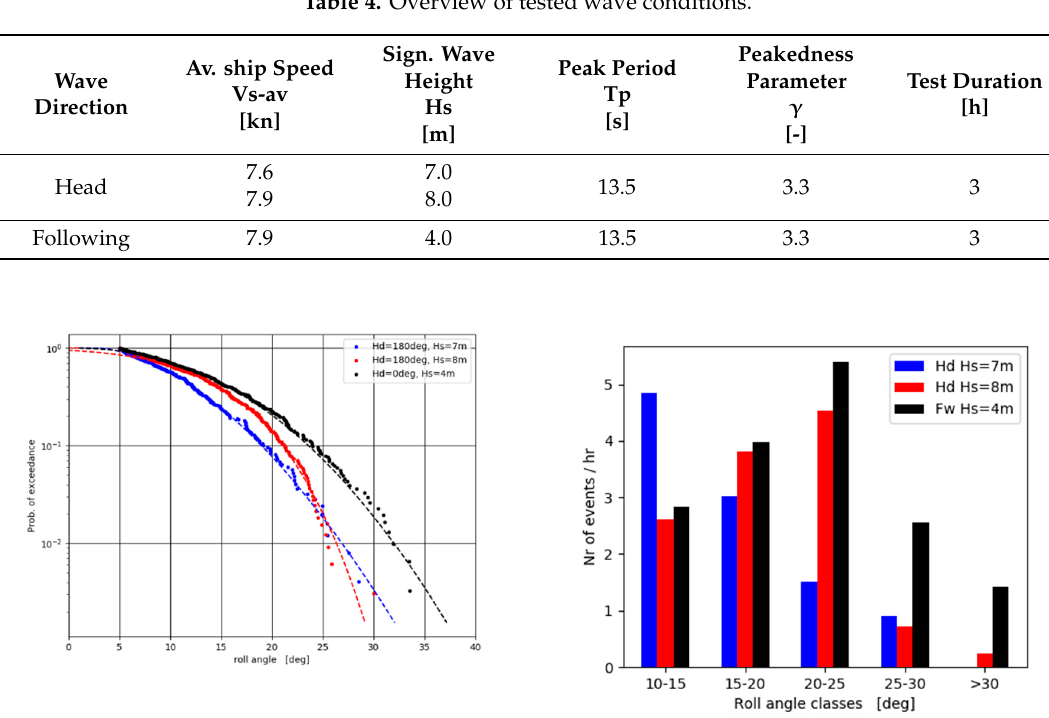
Table 4. Overview of tested wave conditions.